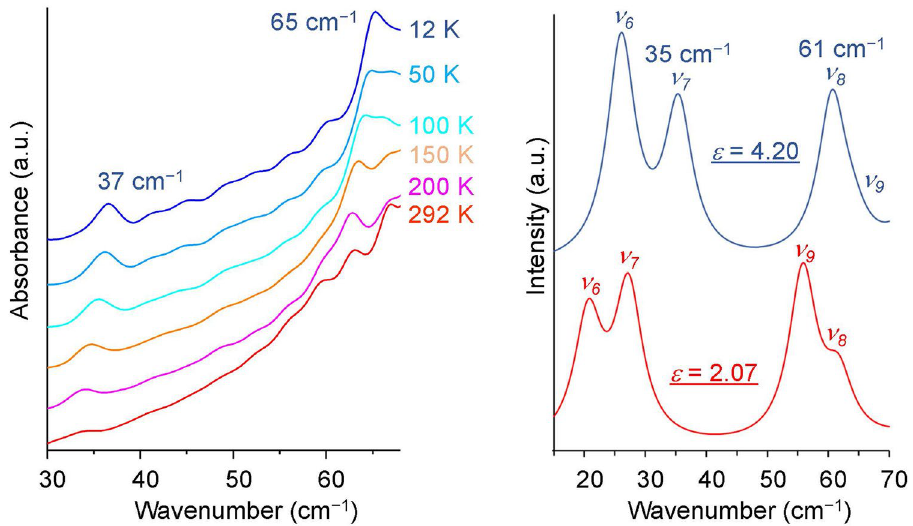
Figure 5. Experimental (left) and calculated (right) THz spectra of MPC. Both of these spectra are vertically offset. The FWHM of calculated spectra is set to the same value as that of the experimental peak at 37 cm −1 at 12 K (FWHM = 2.8 cm −1 ). The four modes obtained in the calculations are denoted as ν 6 – ν 9